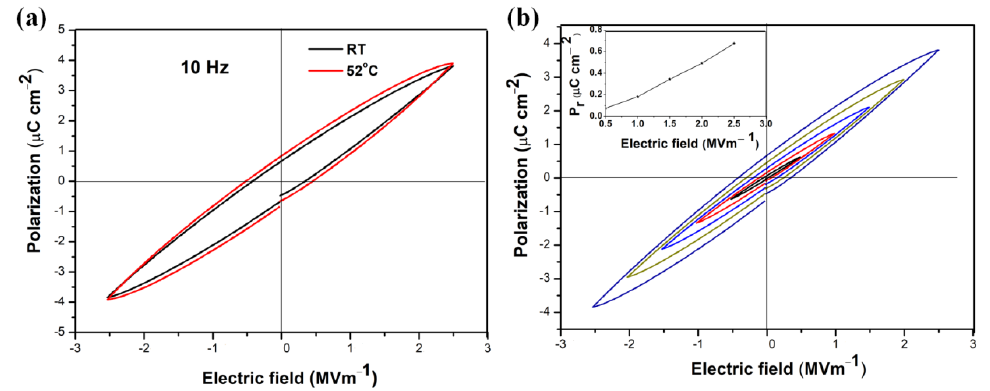
Figure 6. ( a ) P-E loops measured at RT and 52 °C at 10 Hz. ( b ) P-E loops measured at different electric fields at RT, with the inset showing the remanent polarization ( P r) versus electric field. Note that the bimodal structured KN-BT(9/1) bulk ceramic sintered at 1050 °C using the IAGG method was selected for the analysis.